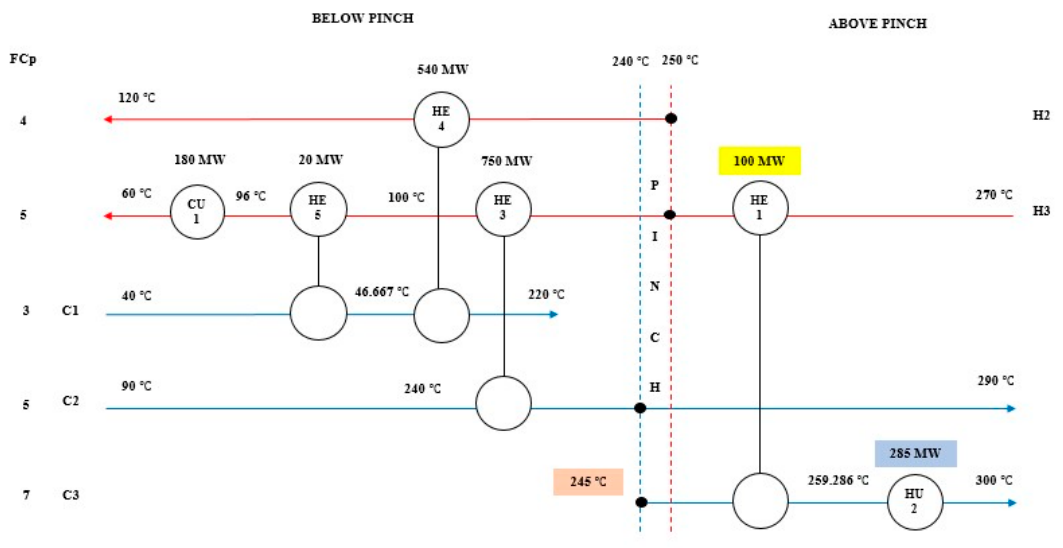
Figure 12. HEN design with increasing T S for cold stream at the pinch. Observation 7. Decreasing T S for a hot or cold stream above the pinch results in increasing Q H